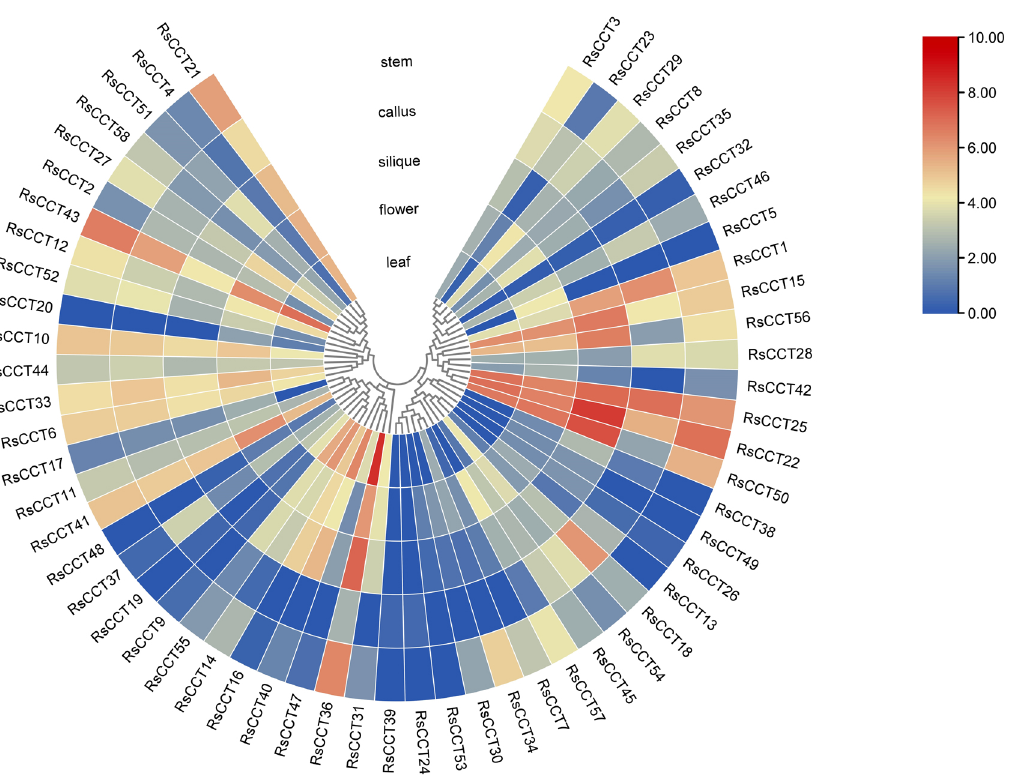
Figure 6. Tissue-specific expression pattern of RsCCT genes. The heatmap was constructed based on the log2 (FPKM + 1) values of RsCCT genes. Red and blue, respectively, indicate higher and lower transcript abundance.